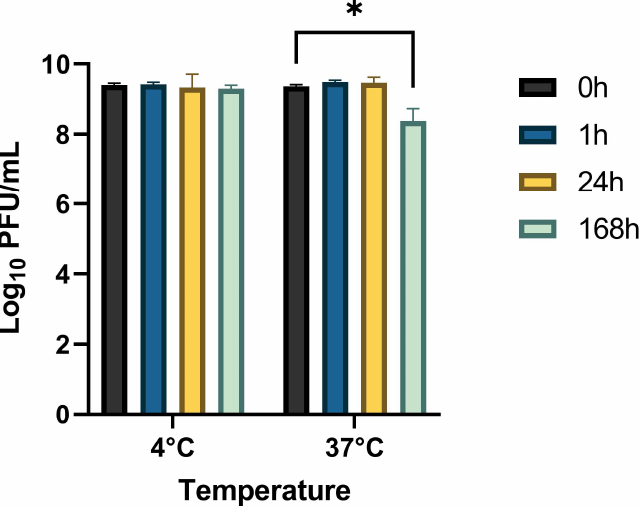
Figure 4. Stability of StaphLyse™ in milk at two temperatures. The average of triplicate samples is presented, and error bars represent SEM. Asterisks indicate significant differences ( p < 0.05) for each time point compared to the respective time of 0 h for that temperature.